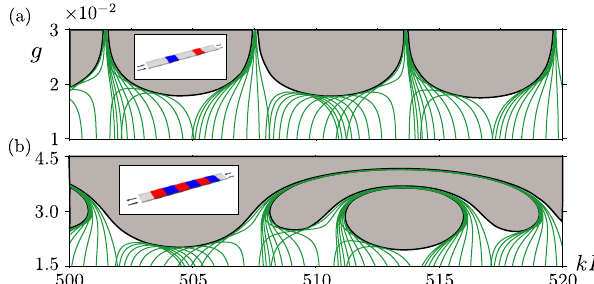
FIG. 2. Eigenvalues k (green lines) of the Helmholtz equation n [Eq. (1)] in the bounded domain, with Robin BCs as defined in Eq. (7). Only the real eigenvalues below the PT threshold are shown as a function of the gain or loss parameter g . (Altogether, ten different values of the boundary parameter (cid:2) 2 ½(cid:2) 500 ; þ 500 (cid:3) are used.) The envelope of the eigenvalues in this bounded system corresponds exactly to the exceptional line (black), which separates the unbroken (white regions) from the broken (gray regions) PT phases in the corresponding unbounded scattering problem. Results are shown for (a) a two-layer setup as displayed in Fig. 1(a) as well as for (b) a more complicated system featuring altogether six layers of loss and gain (see the